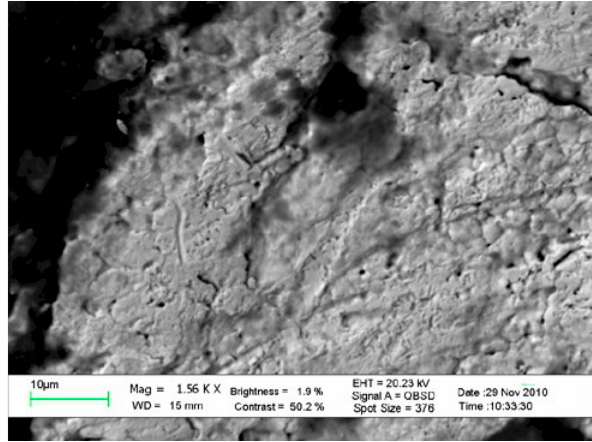
Figure 9. Modification of the metal microstructure (due to recrys- tallization) inside the incision